Question: Describe this figure in one sentence.
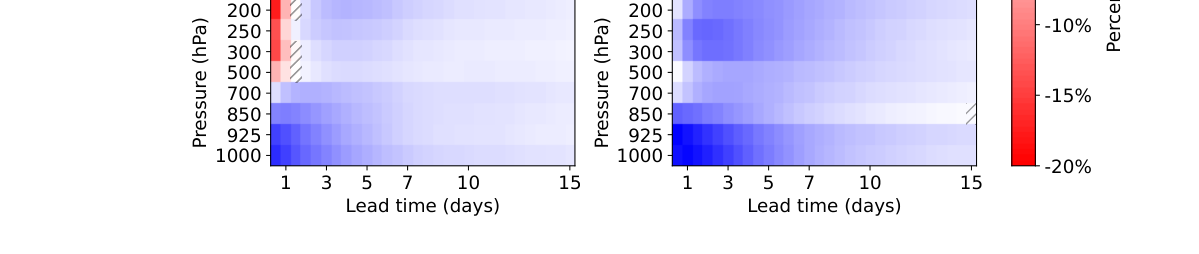
Answer: | CRPS scores for GenCast versus ENS in 2019. The scorecard compares CRPS skill between GenCast and ENS across all variables and 8 pressure levels, where dark blue indicates GenCast is 20% better than ENS, dark red indicates GenCast is 20% worse, and white means they perform equally. The results indicate that GenCast significantly outperforms ENS (𝑝< 0.05) on 97.4% of all reported variable, lead time, and level combinations. Hatched regions indicate where neither model is significantly better.